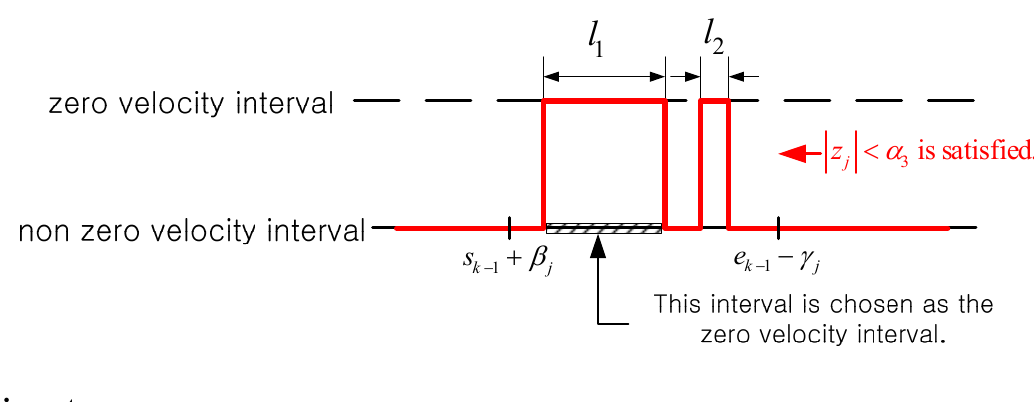
Figure 11. Zero velocity interval